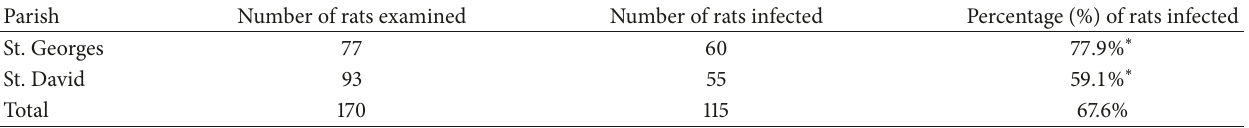
Table 1: Prevalence of Cysticercus fasciolaris in brown rats of